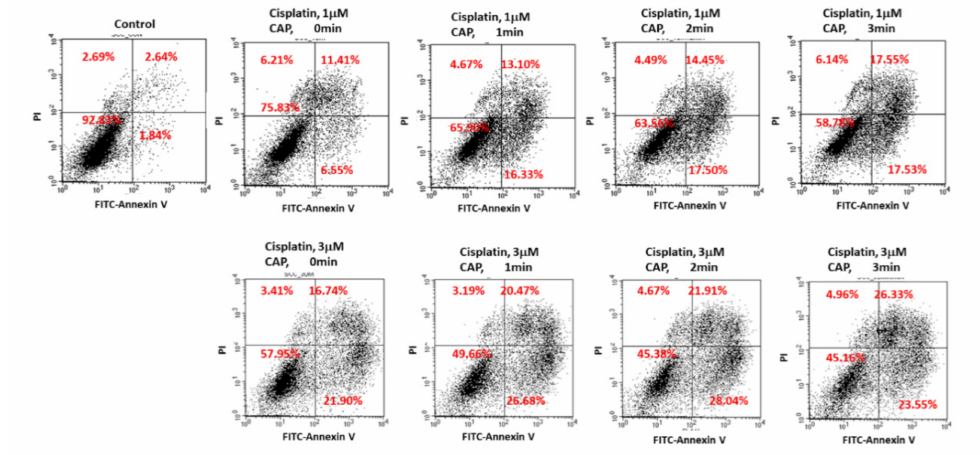
Figure 9. Flow cytometry of apoptosis / necrosis analysis of SCC-15 cells. SCC-15 cells treated with cisplatin / CAP as described in Figure 4 were then stained with fluorescein isothiocyanate (FITC)–annexin V for apoptosis and propidium iodide (PI) for necrosis. Apoptosis / necrosis analysis of SCC-15 cells using flow cytometry under CAP exposure and